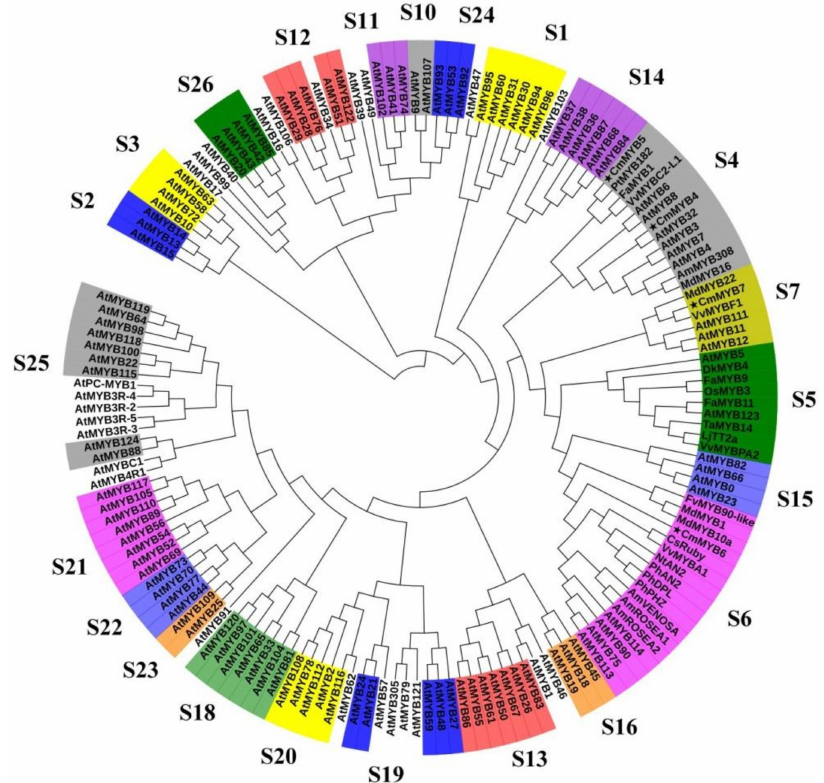
Figure 1. Phylogenetic relationships of MYBs in other plants compared to the four MYBs from the chrysanthemum. Full-length amino acid sequences of MYBs from all species were first aligned using ClustalW in MEGA. The phylogenetic tree was constructed according to the neighbor-joining method. Branches corresponding to partitions reproduced in less than 50% of the bootstrap replicates were collapsed. The evolutionary distances were computed using the p -distance method. All ambiguous positions were removed for each sequence pair. Stars represent the four CmMYB proteins. S represents subgroup. The GenBank accession numbers of each species are shown in Supplementary Table